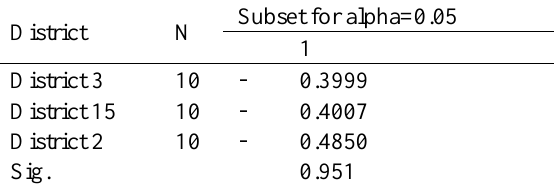
Table 6. Tukey's test results on homogeneous zone classification and comparison of districts 2, 3, and 15 Subset for District N